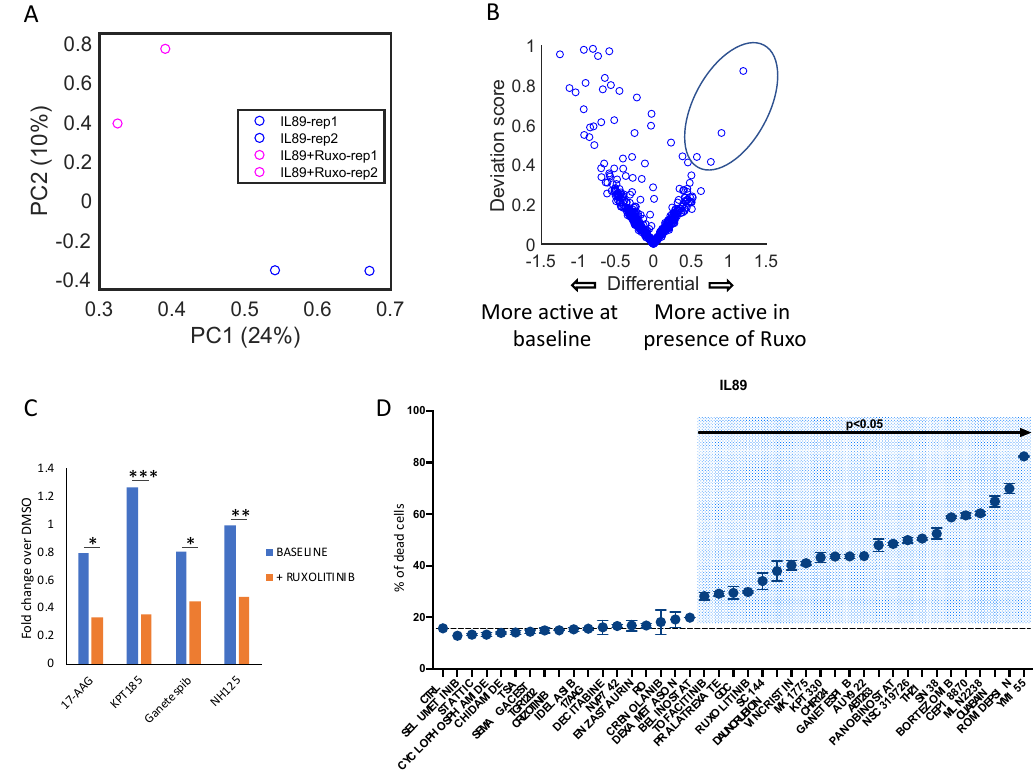
Figure 6. High-throughput screening of IL89_CL#3488 in the presence of ruxolitinib reveals potential synergic combinations. ( A ) Principal component analysis based on the drug response data of IL89_CL#3488 in the absence or presence of ruxolitinib (high-throughput drug screening (HTS) compounds library: 433 drugs, 1 µM, 72 h; ruxolitinib 0.5 µM, 72 h) showed a high degree of concordance among replicates. ( B ) Volcano plots highlighting the overall responses to the drug screening library of IL89_CL#3488 in the absence or presence of ruxolitinib (HTS compounds library: 433 drugs, 1 µM, 72 h; ruxolitinib 0.5 µM, 72 h). Each dot represents a single drug. Dots on the left represent drugs with a higher therapeutic effect in the absence, and on the right in the presence, of ruxolitinib. ( C ) Histogram showing the response of IL89_CL#3488 to 17-AAG, KPT185, ganetespib, and NH125 (1 µM, 72 h) in the absence or presence of ruxolitinib (0.5 µM, 72 h). ( D ) Percentage of IL89_CL#3488 cell death after treatment with a battery of 40 compounds. Standard deviations are reported. Data are representative of at least three independent experiments, and values are expressed as the average ± standard deviation. p -values were calculated using the student t-test and corrected for multiple comparisons using the Bonferroni method. * p < 0.05, ** p < 0.01, *** p < 0.001.